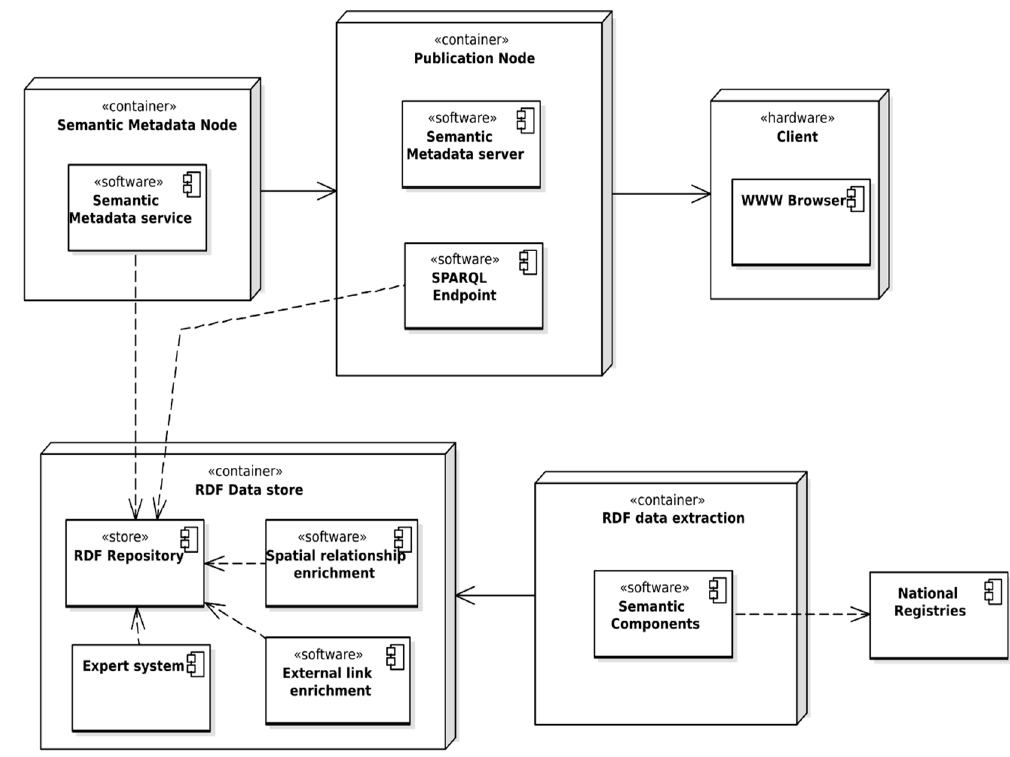
Figure 2. Component model.